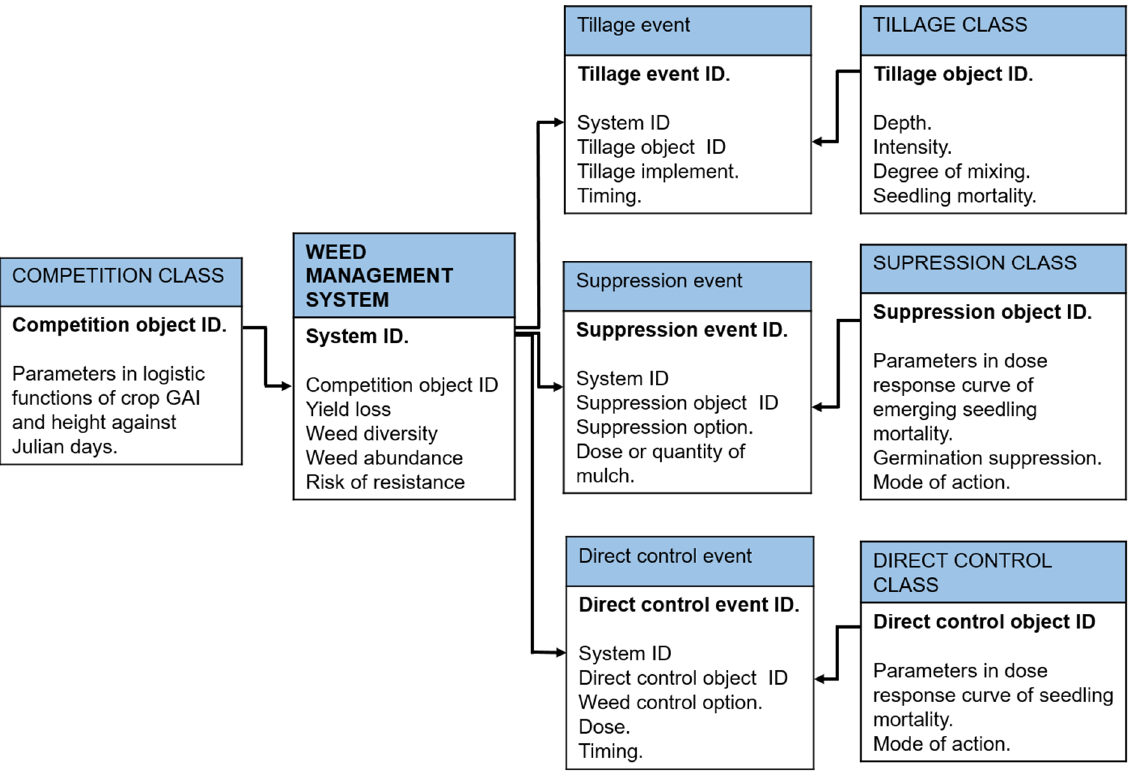
Figure 4. Organisation of classes and events in a data model. Weed control ‘events’ associated with objects in the relevant classes combine to define the weed management system; the level at which outcomes are predicted (weed abundance, diversity, yield loss and evolution of resistance). The competition of the crop canopy is defined by an additional class.